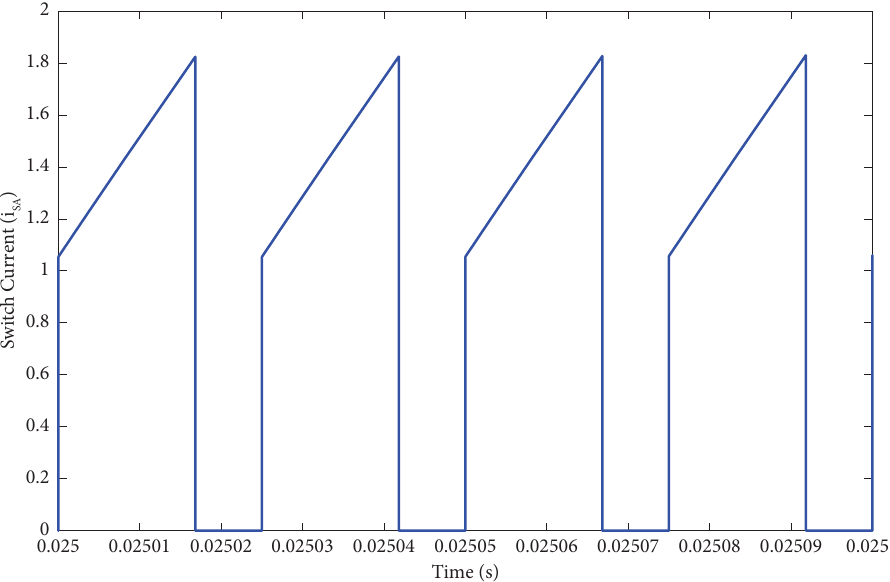
Figure 10: Te switch S A simulated current waveform.